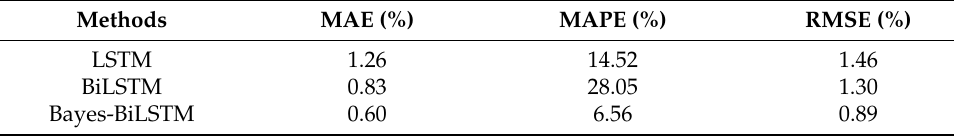
Table 6. Comparison of the estimation results of different methods.